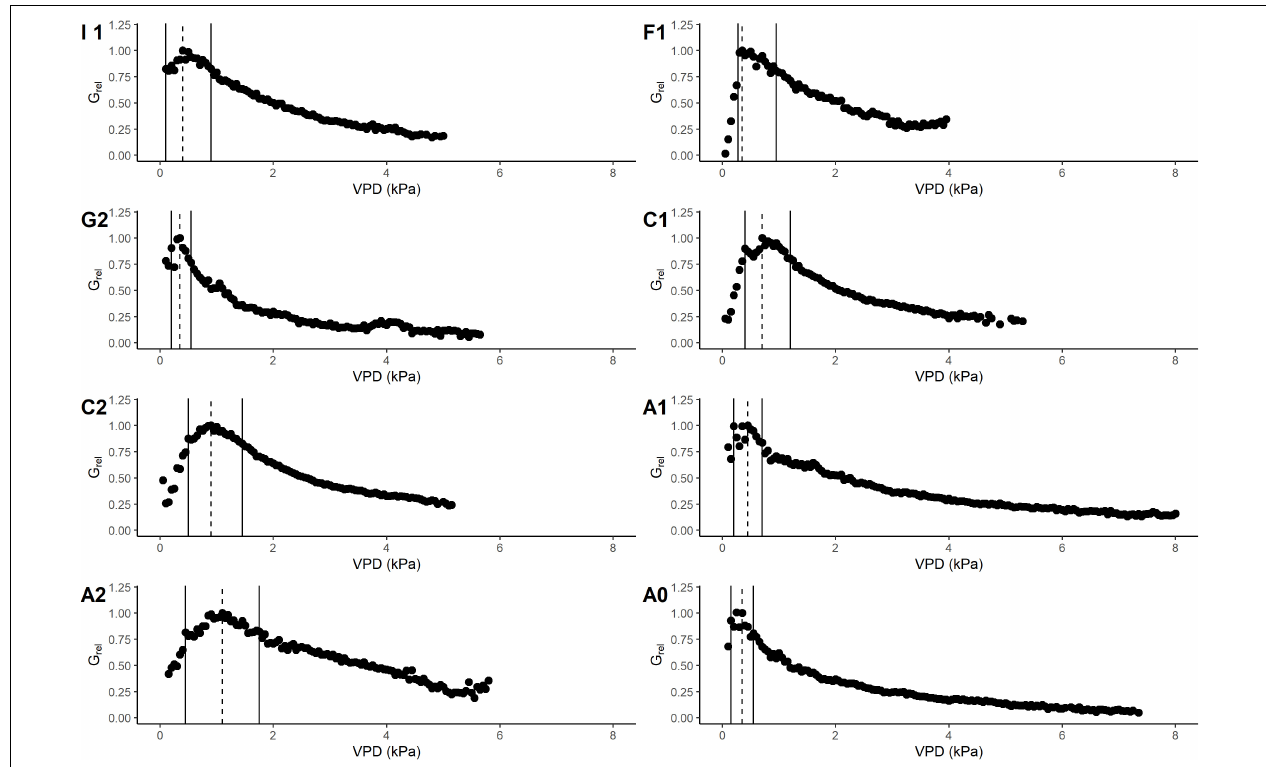
FIGURE 4 | Response of G rel to VPD class (kPa) in different sites. Study areas are marked with the corresponding site ID as described in “Materials and Methods” section. Markers refer to mean values of G rel in each VPD class (0.1 kPa). Data are binned using 0.1 kPa bin size. Vertical dashed line shows the VPD value at maximum G rel , while the solid line shows the limits of VPD value at 80% of the G rel